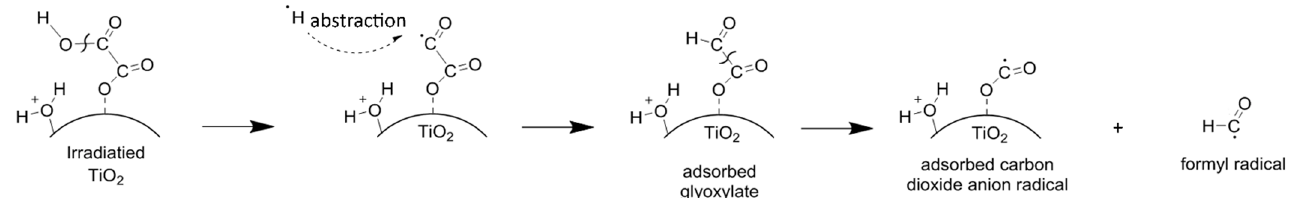
Scheme 1. The mechanism proposed for the cleavage of C–O bonds before the addition of hydrogen atoms to produce adsorbed aldehyde molecules. Adapted from [15,28], copyright 2020, American Chemical Society.